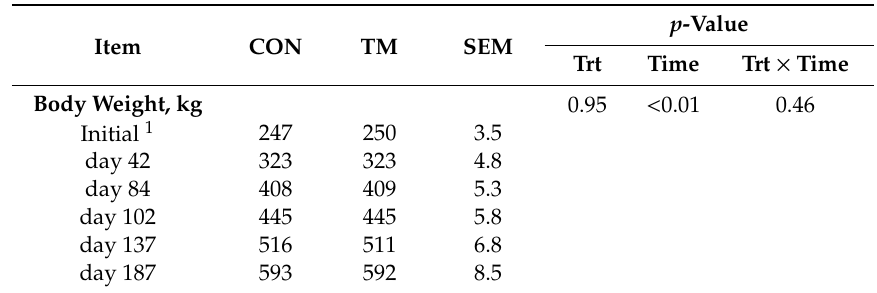
Table 2. E ff ects of maternal supplementation of trace minerals on the subsequent steer body weight (BW) during the finishing phase.